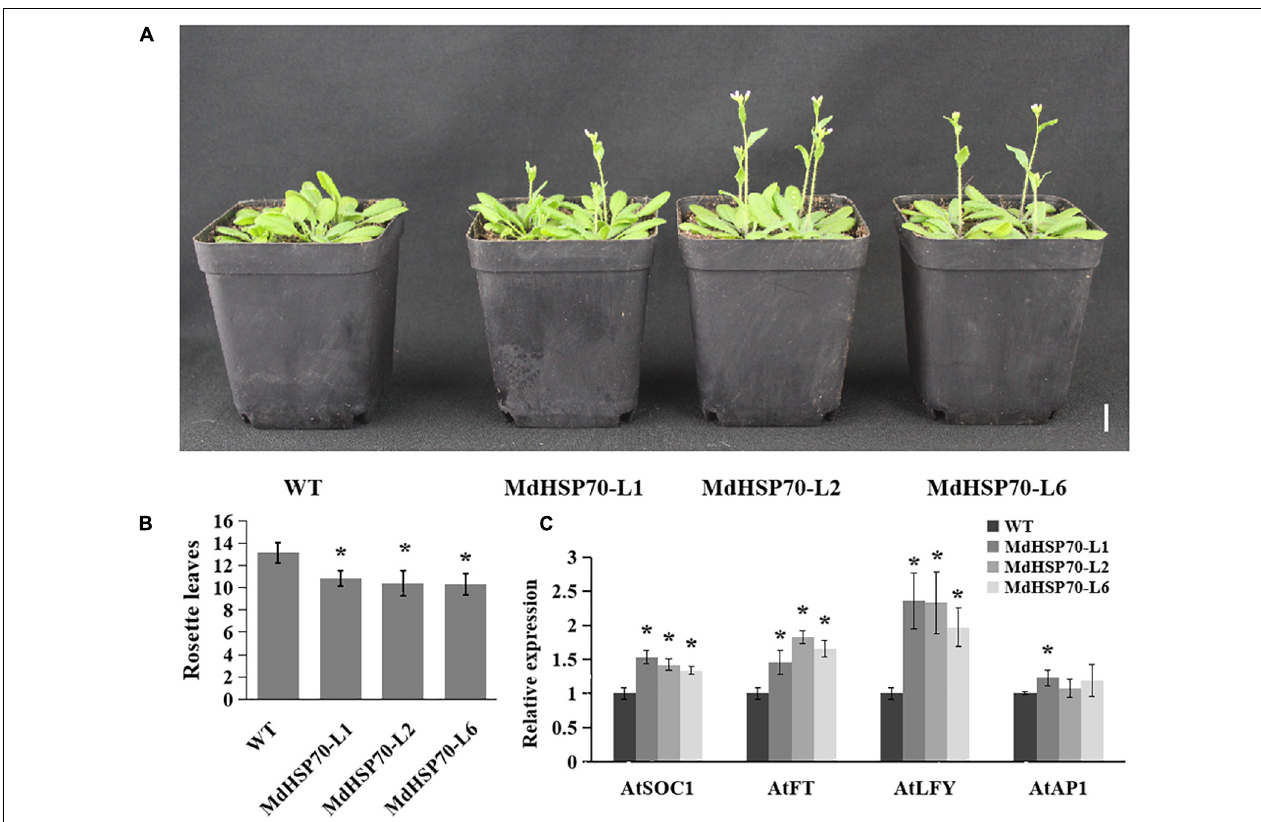
FIGURE 7 | MdHSP70 promotes flowering in Arabidopsis. (A) Phenotype of the MdHSP70 -OE Arabidopsis lines for flowering time. Bar = 2 cm. (B) Statistical analysis of rosette leaves of Arabidopsis thaliana during bolting ( n = 15 plants per line). (* P < 0.05). (C) Relative expression levels of flowering genes ( AtFT , AtLFY , AtSOC1 , and AtAP1 ) in WT and MdNup54 -OE lines. (* P <